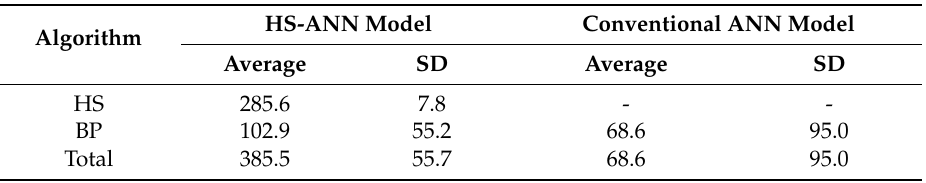
Table 6. Statistical characteristics of computational time (unit = s